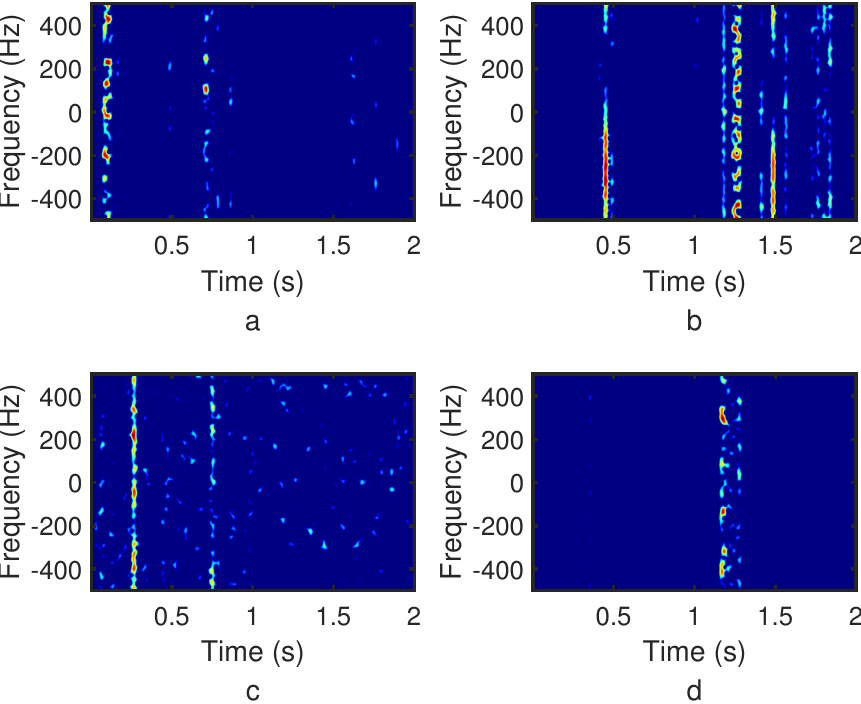
Figure 2. This figure displays the Margenau-Hill-Spectrogram distribution time-frequency images of the measured WiFi signal regarding ( a ) the marching-in-place exercise, ( b ) rope skipping, ( c ) arms rotating, and ( d )